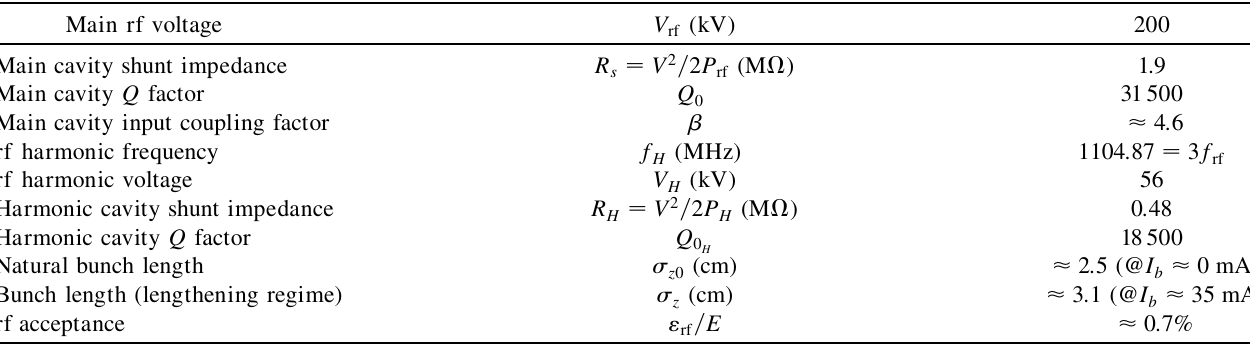
Natural bunch length Bunch length (lengthening